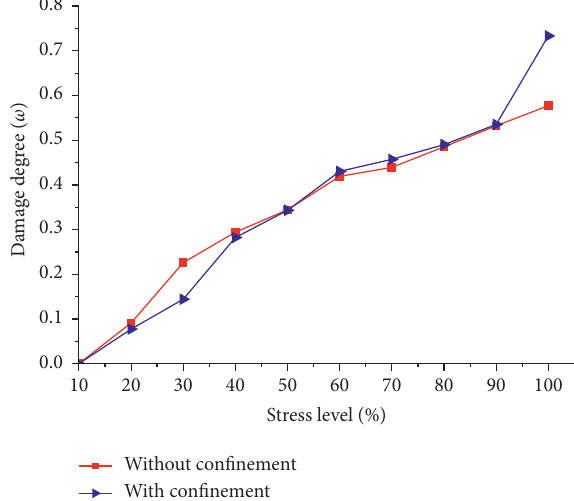
Figure 13: Relationship between damage degree and different stress